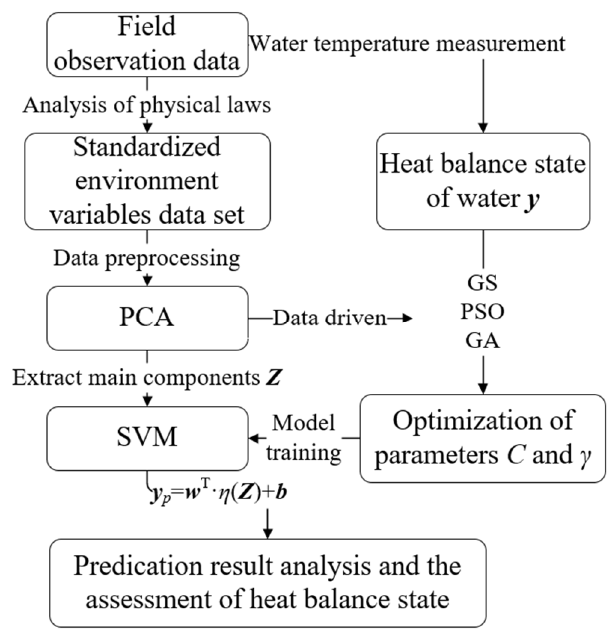
Figure 4. The calculation flow chart.